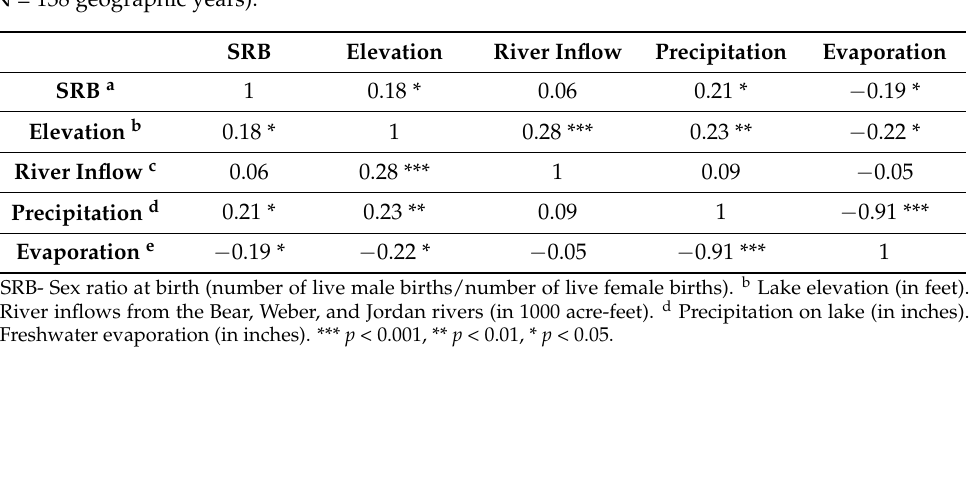
Table 2. Pearson correlation coefficients of sex ratio at birth with four measures of Great Salt Lake (N = 138 geographic years).